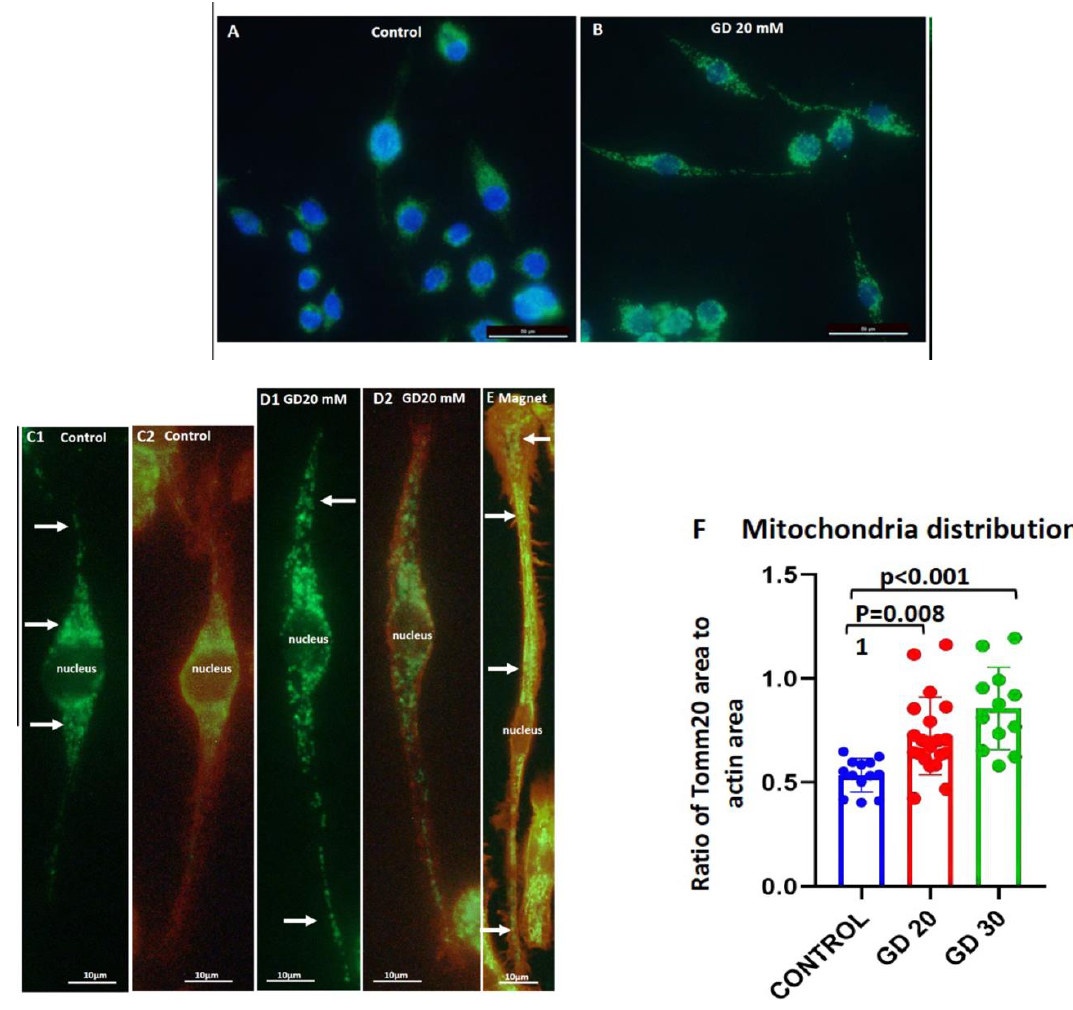
Figure 8. Dotarem and the magnetic field gradient caused redistribution of mitochondria. ( A – D ) Im- ages of RAW 264.7 macrophages untreated (control) and treated with 20 and 30 mM Dotarem (GD20, GD30) stained with rhodamine–phalloidin (red) for actin and immunostained with mitochondrial marker Tomm20 (green) antibody. The nuclei were stained with DAPI (blue). Panels ( A , B , C2 ) are merged images. ( E ) A mouse peritoneal macrophage that was grown on the magnet setup described by Wosik et al. (2018) and immunostained with mitochondrial marker COX4 (green) antibody in the merged image. In the control, the untreated cells of the mitochondria were located around and in the close vicinity of the nucleus (arrows) with very infrequent mitochondria observed in cell extensions. In the Dotarem-treated or magnetic field gradient exposed macrophages, mitochondria were distributed toward the cell extensions (arrows). ( F ) The graph shows that the differences in the mitochondria’s distribution (calculated from three experiments) between the control and the Dotarem (GD)-treated cells were statistically highly significant.